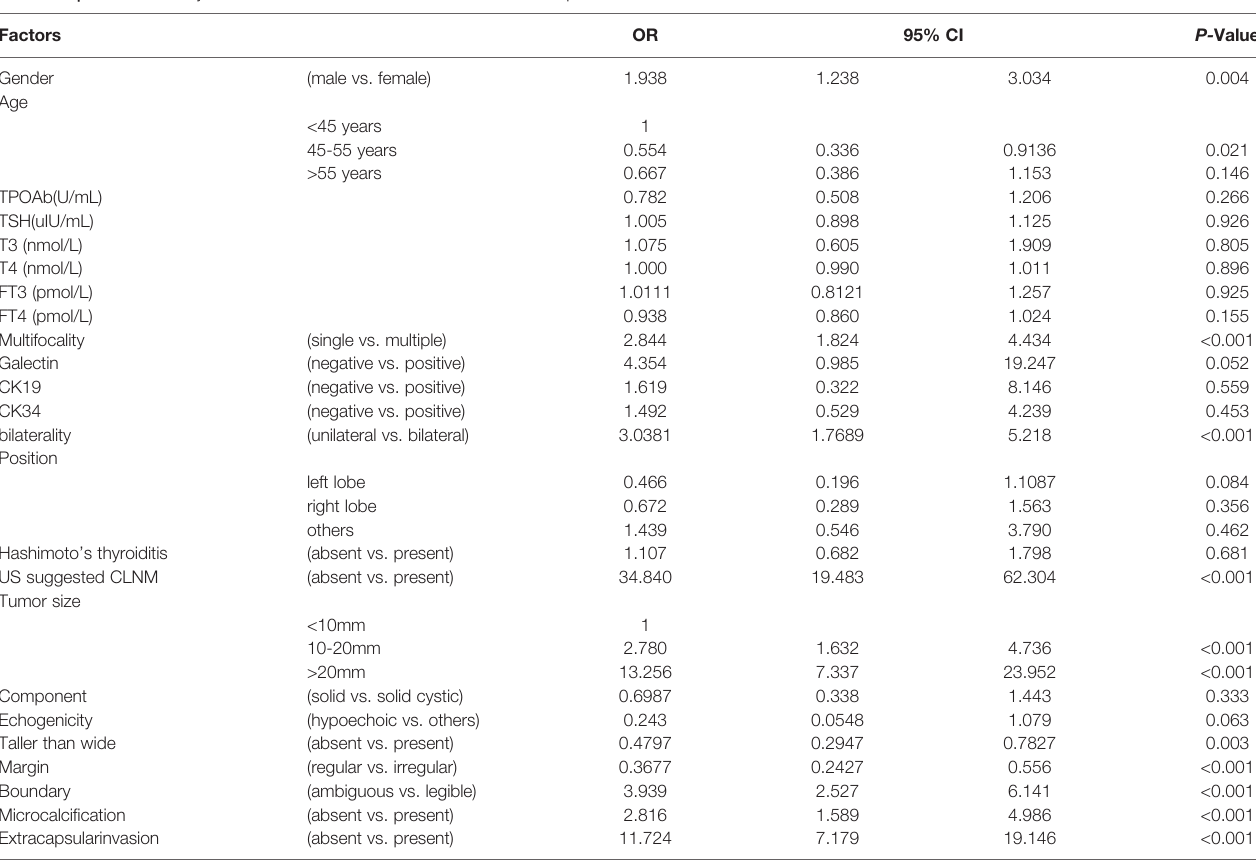
TABLE 2 | Univariate analysis of risk factors associated with CLNM in PTC patients. Factors